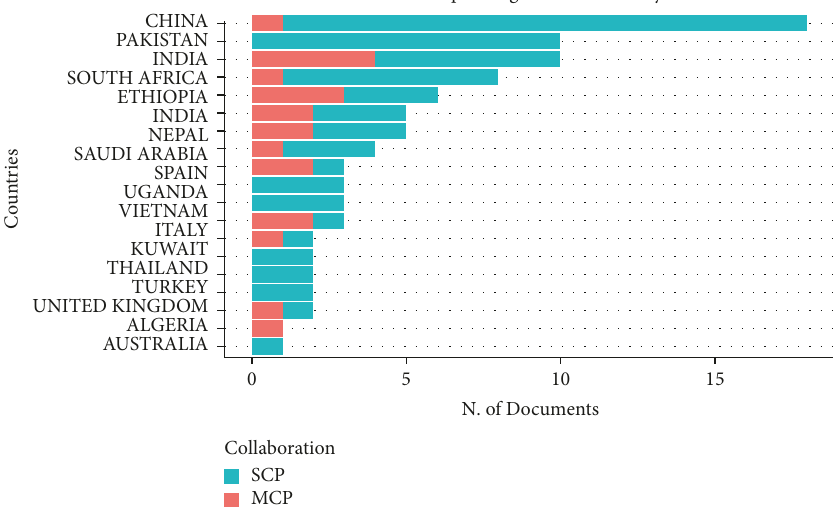
Figure 5: Top 20 corresponding author countries.